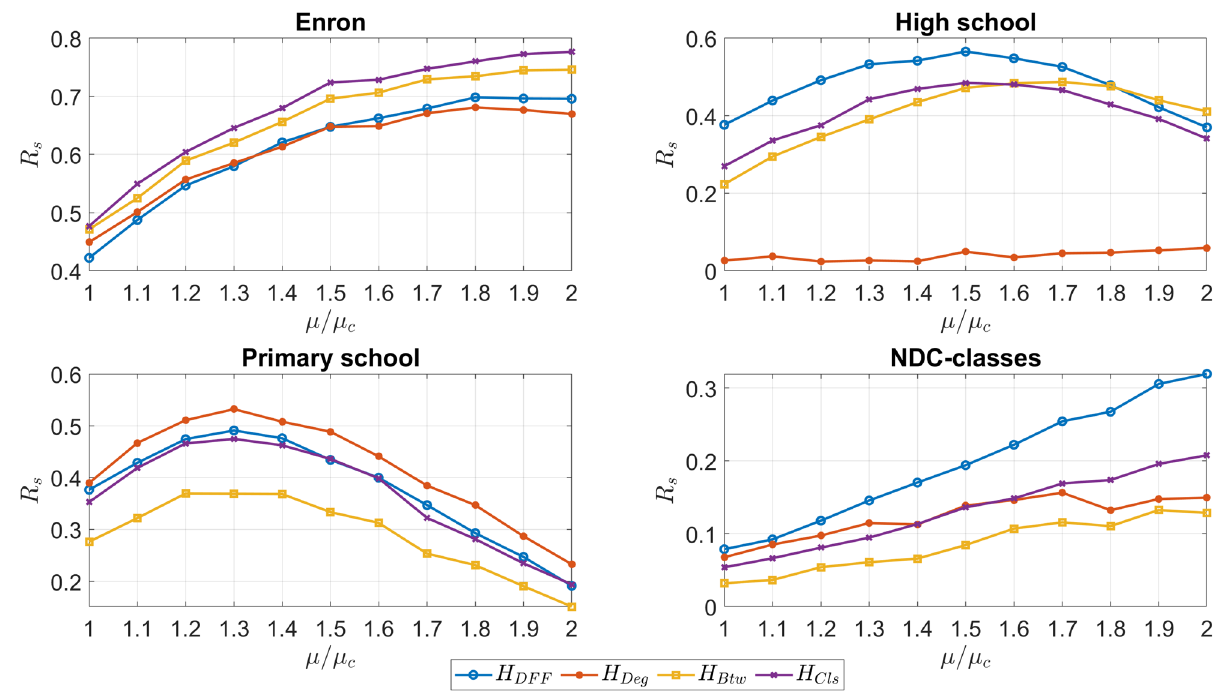
Figure 3. Varying infection rate when using the SIR model on the selected networks. The ratio of hyperedges removed in each trial is the top 5% of influential hyperedges found by each of the centrality measures. A greater diffusion index or R s indicates that the method is more